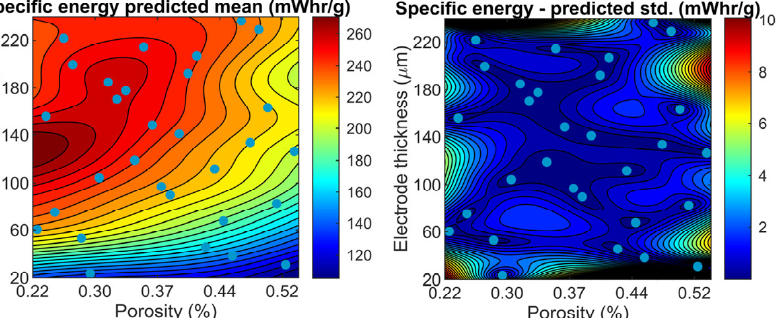
Figure 1. Gaussian process regression model—Specific energy of the 18650 LIB cell. The left figure shows the predictive mean 𝐟̅ ∗ and the right figure shows the predictive standard deviation, i.e., cov (𝐟 ∗ ) , of the GP regression model. The blue dots are the samples used to train the surrogate model.